Question: Name the type of graph shown.
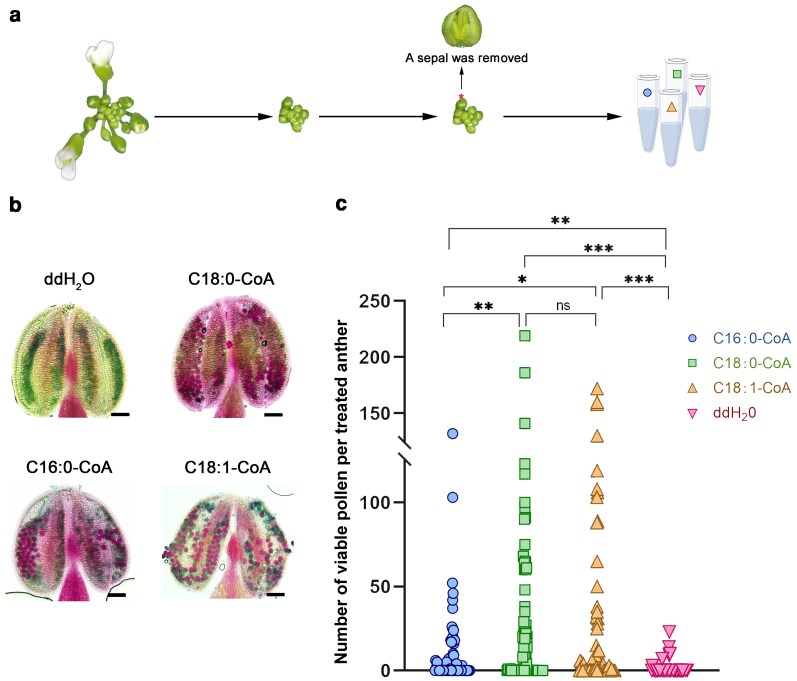
Answer: scatter